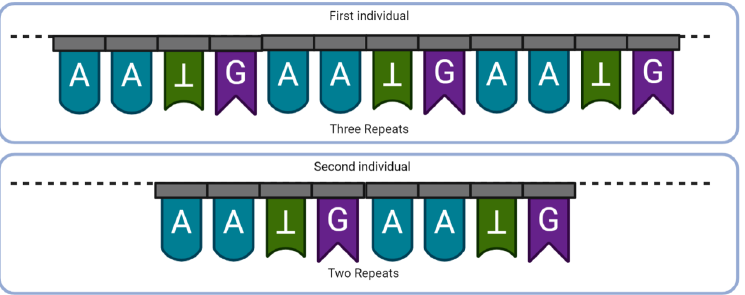
Figure 9. Short tandem repeats